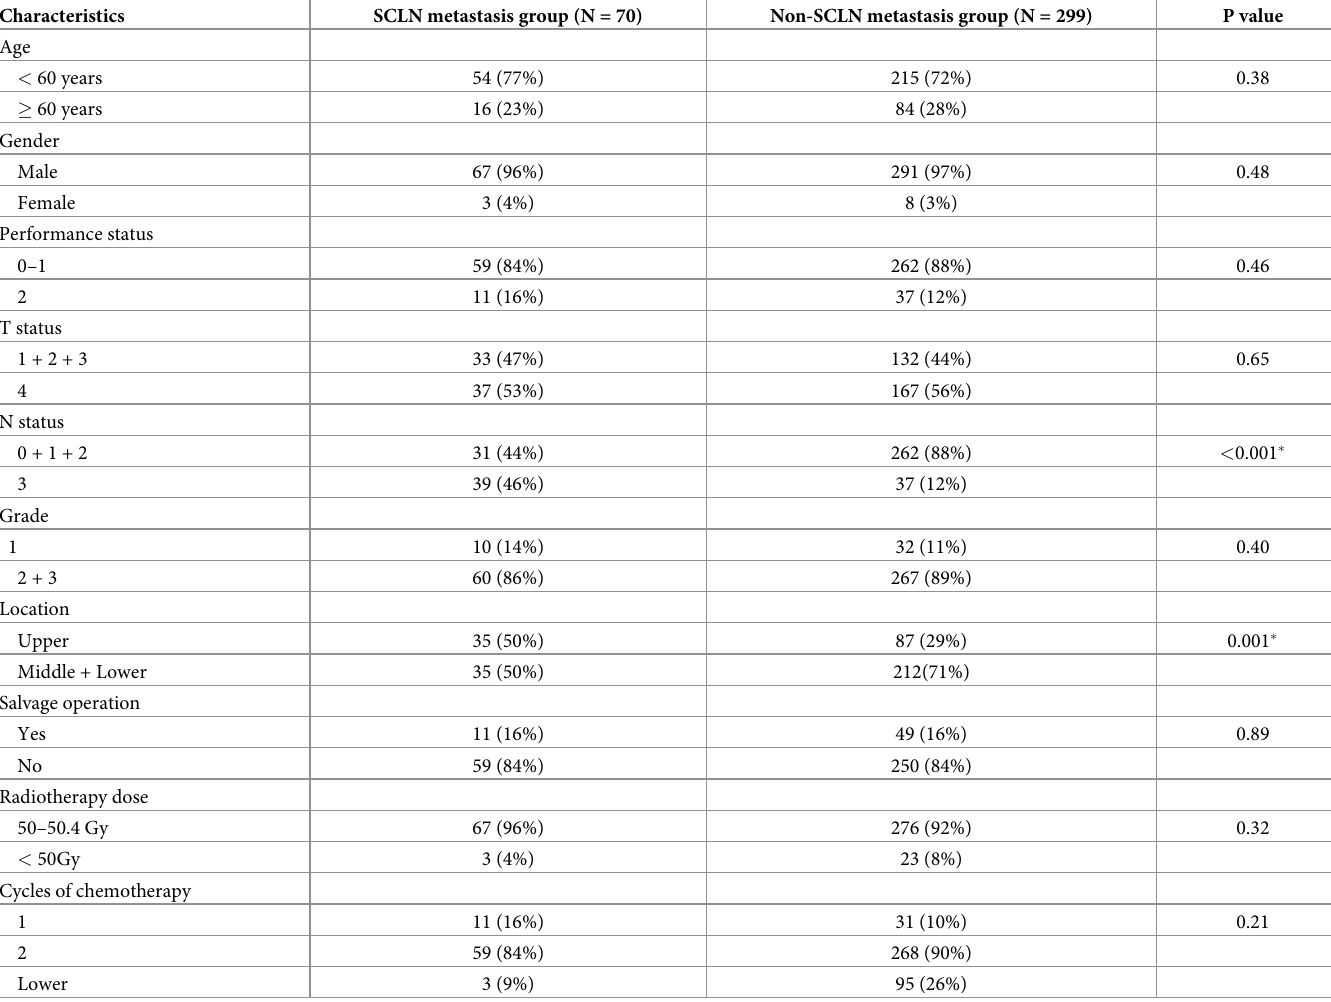
Table 1. Clinicopathological parameters in 369 locally advanced esophageal squamous cell carcinoma patients with/without supraclavicular lymph node (SCLN) metastasis receiving curative CCRT.